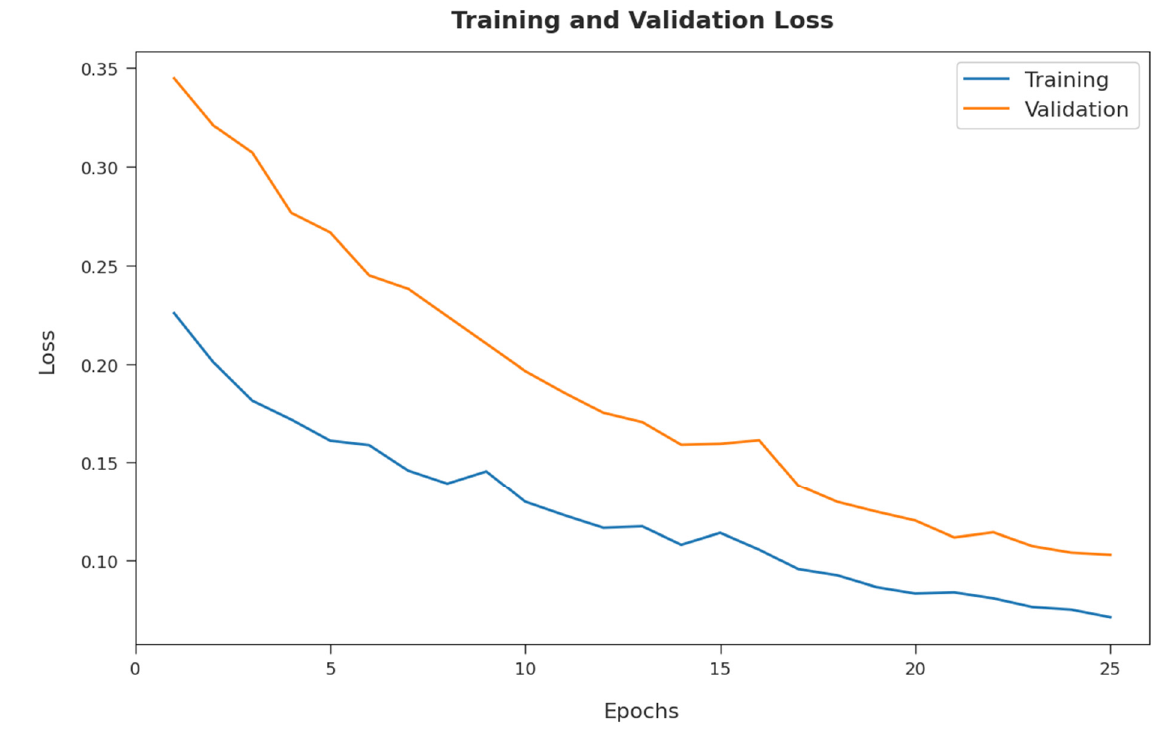
Figure 8. Loss graph analysis of FSSML-EDM technique.